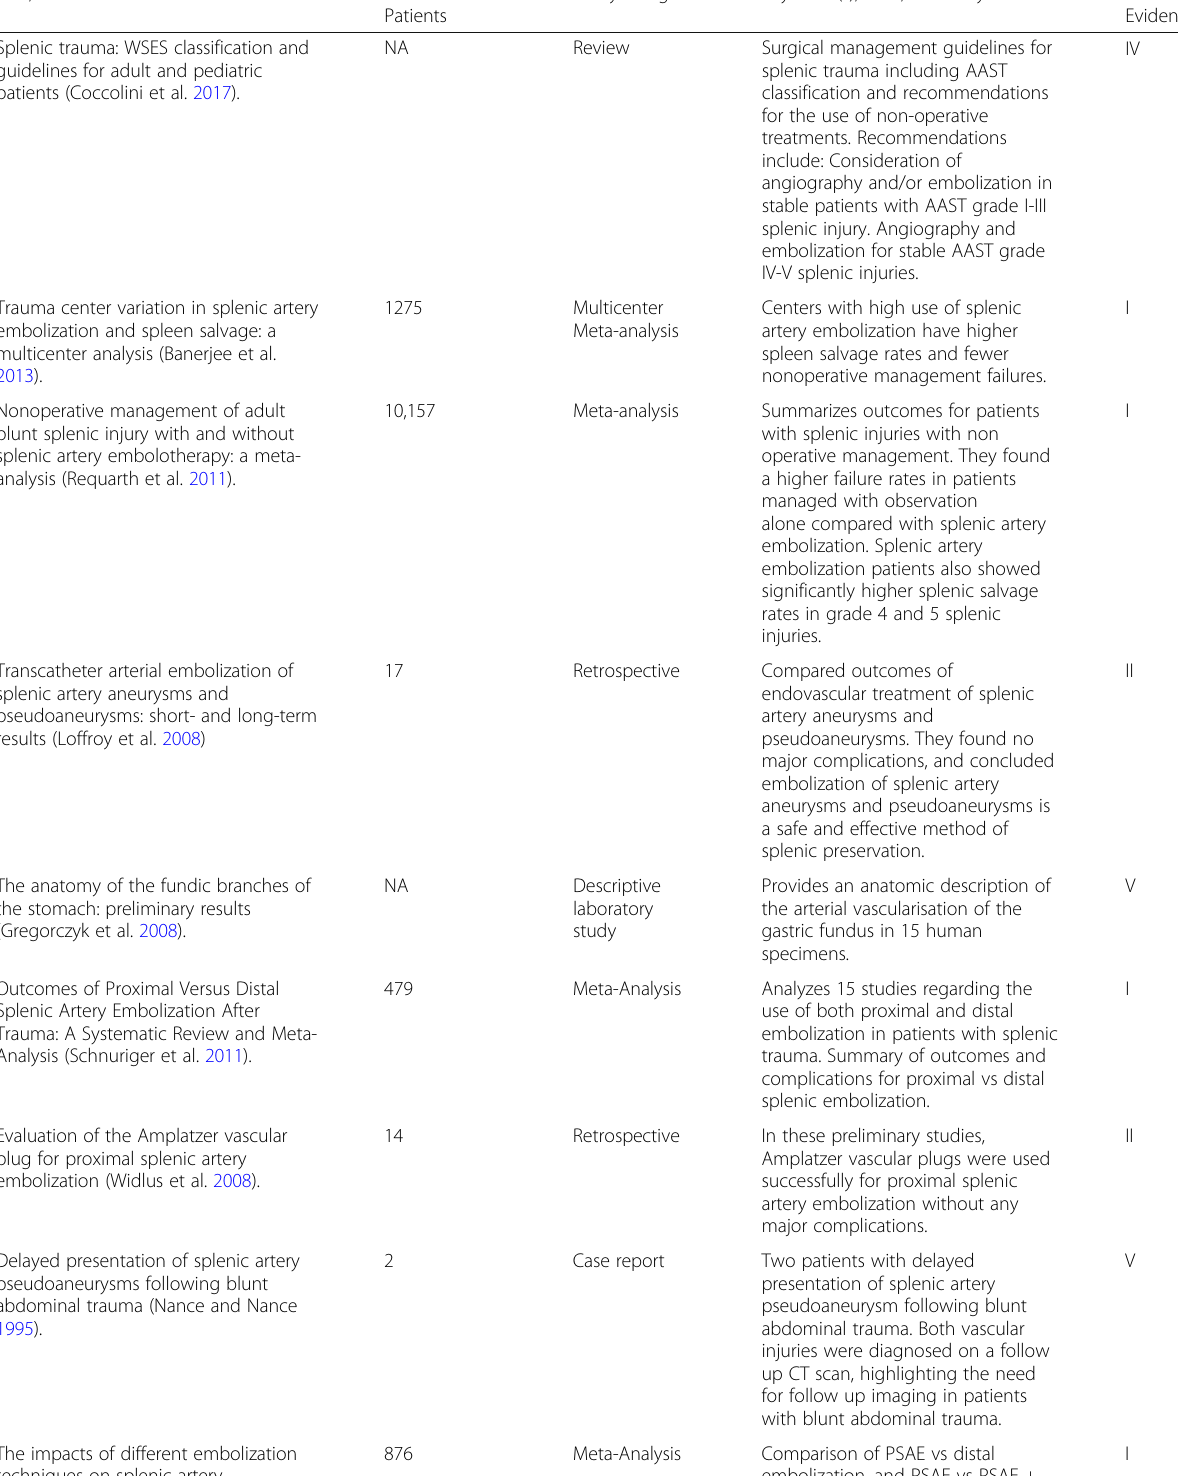
Table 2 Summary table of key studies on splenic embolization with a level of evidence designation. Levels of evidence are defined using the grading system adapted from the American Society of Plastic Surgeons and Johns Hopkins nursing evidence-based practice: Models and Guidelines (Burns et al. 2011; Dang and Dearholt 2017) - (see Table